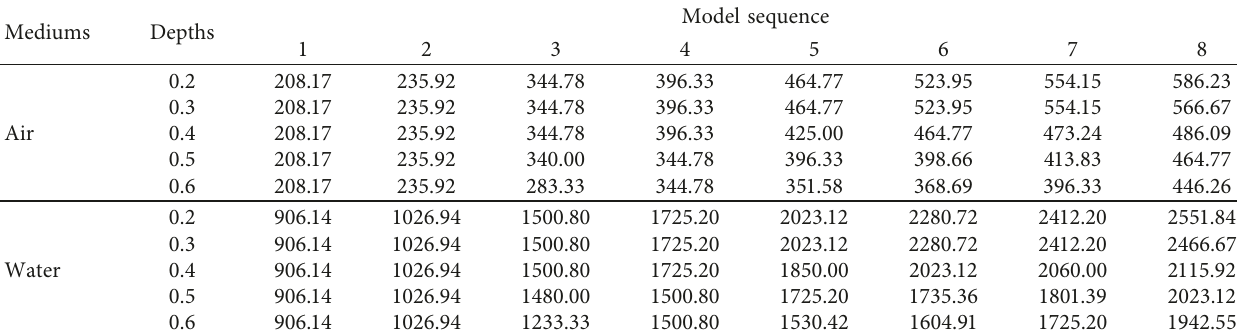
Table 6: The first eight natural frequencies (Hz) of the quadrangular prism acoustic cavity with various cavity depths. Mediums